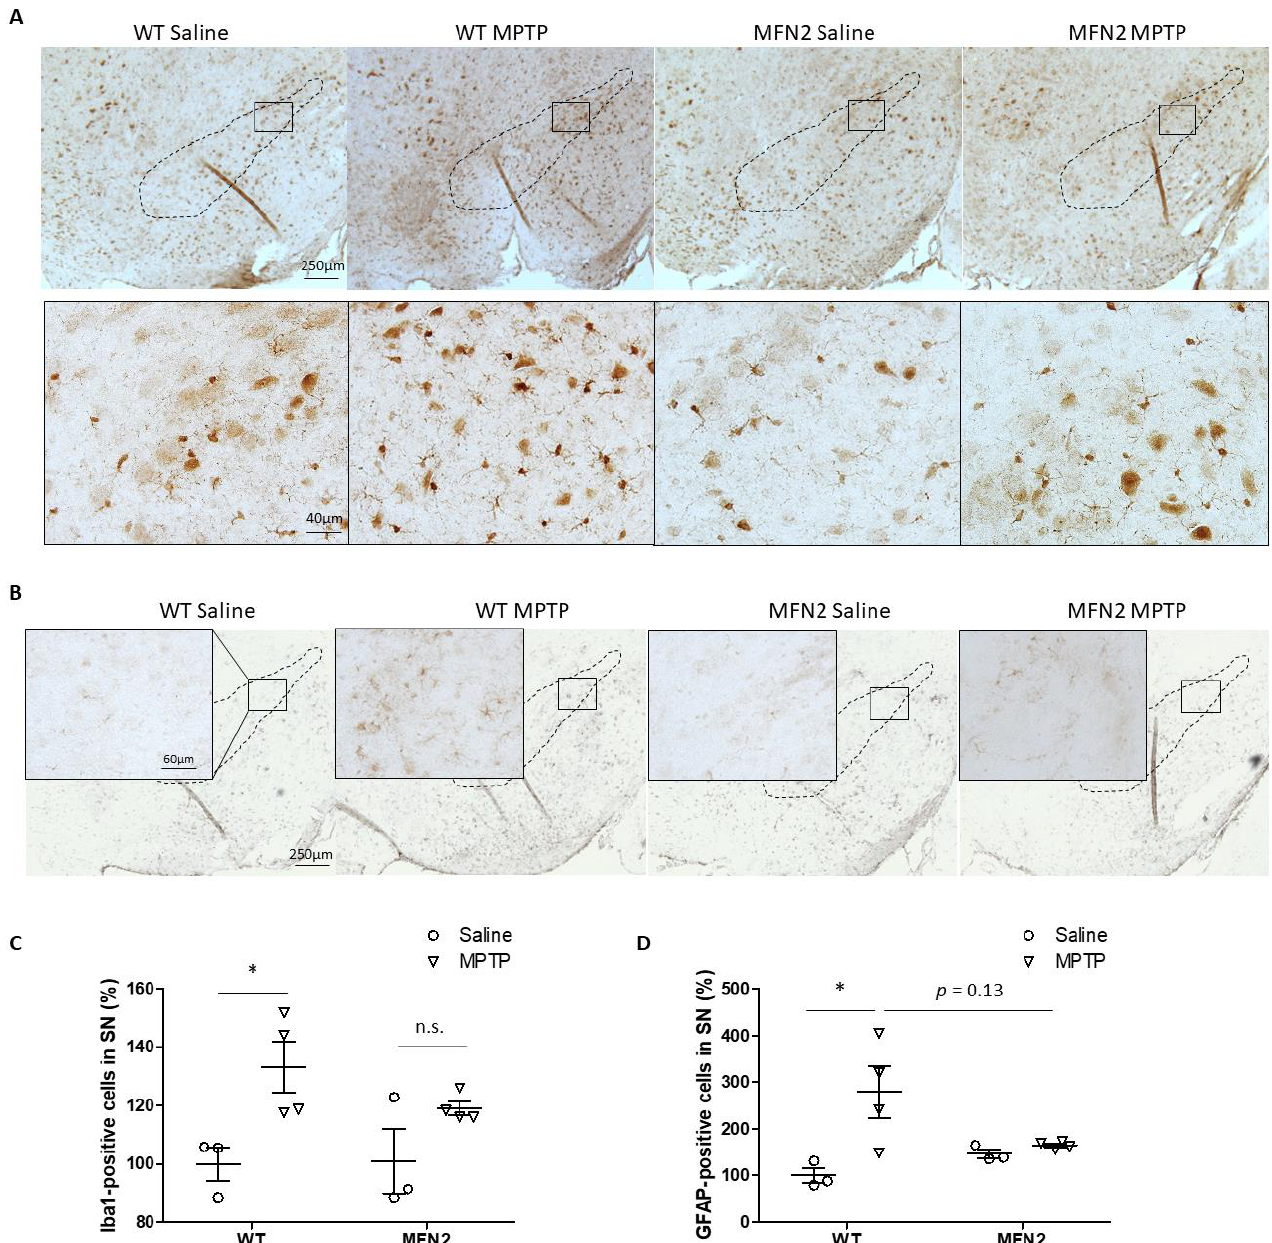
Figure 4. Mfn2 overexpression inhibited MPTP-induced astrocytosis and microgliosis in the SN. Fixed brains of MPTP- or saline-treated mice were immunostained for iba1 and GFAP. Representative pictures of microglia ( A ) and astrocytes ( B ) are shown. Quantification of the relative number of microglia ( C ) and astrocytes ( D ) in the SN (dashed line) is shown ( n = 4; * p < 0.05 compared to the control. n.s., not significant) .